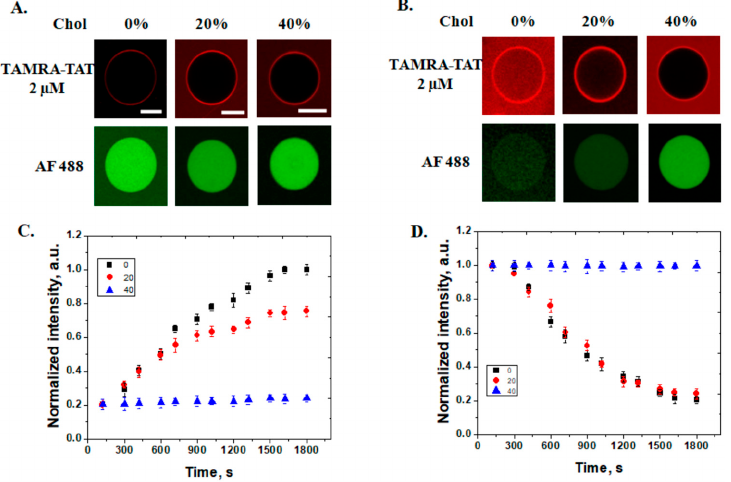
Figure 5. Internalization of TAMRA ‐ TAT peptides and efflux of Alexa Fluor 488 from cholesterol containing GUVs. Interaction of TAT peptides with GUVs containing POPC/POPE/POPS/chol 70/20/10/0 mol%, POPC/POPE/POPS/chol 50/20/10/20 mol%, and POPC/POPE/POPS/chol 30/20/10/40 mol% and release of AF 488, in the lower panel, ( A ) after 5 min and ( B ) after 30 min. ( C ) The time dependence of the normalized fluorescence intensity measured inside GUVs, for different concentrations of cholesterol (POPC/POPE/POPS/chol 70/20/10/0 mol% ( ■ ), POPC/POPE/POPS/chol 50/20/10/20 mol% ( ● ), and POPC/POPE/POPS/chol 30/20/10/40 mol% ( ▲ )) and ( D ) Efflux of AF 488 tracer. Error bars indicate the standard deviation. Scale bars correspond to 20 μ m.